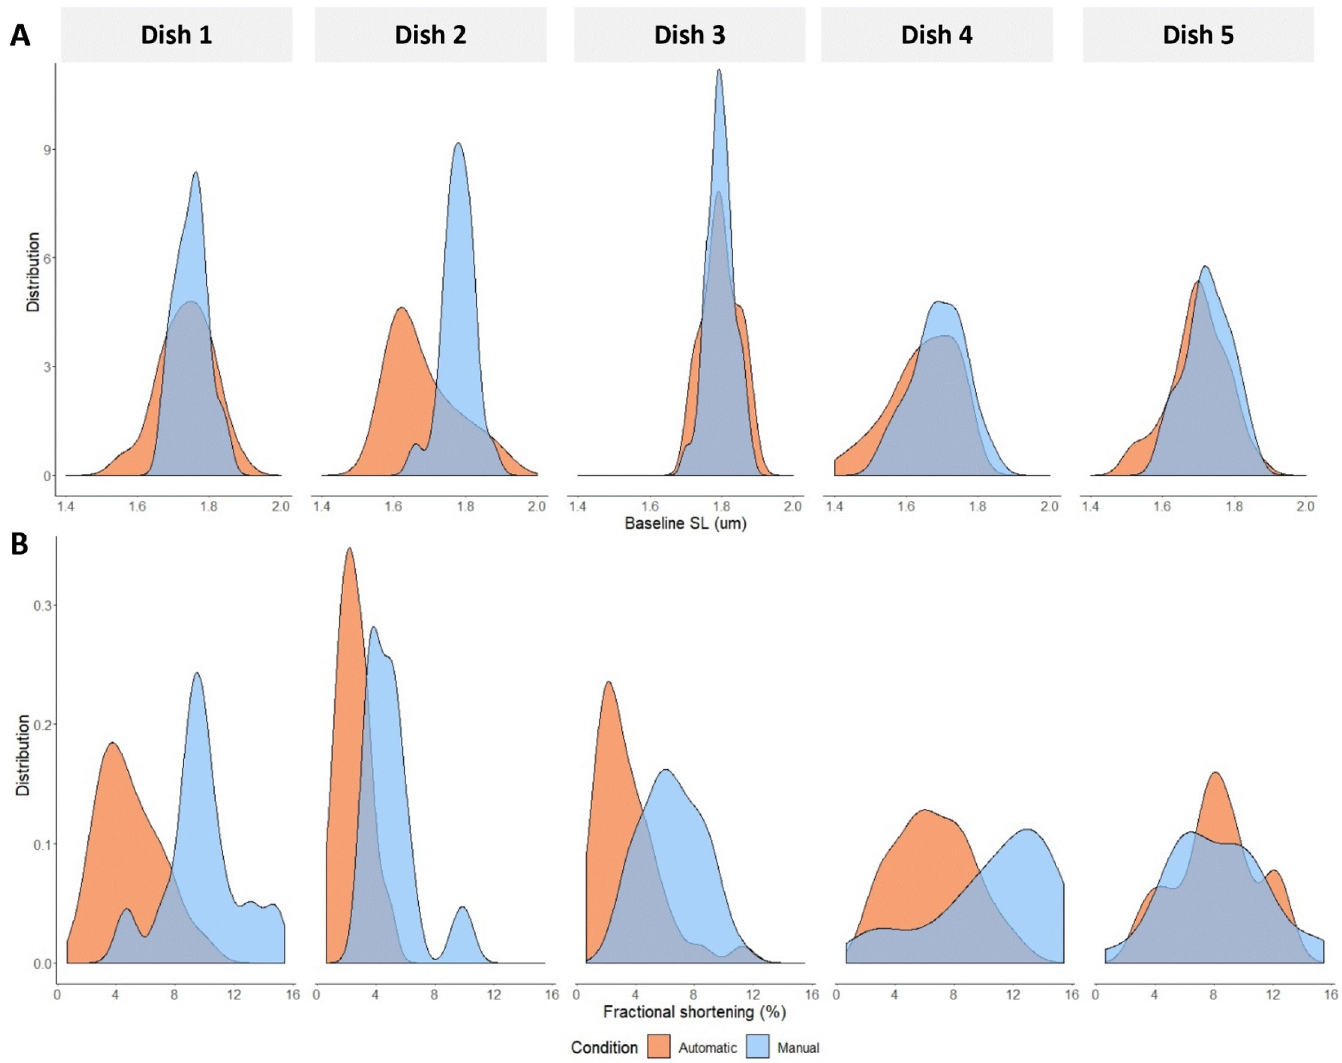
Fig 6. Data distribution of 5 dishes measured manually and automatically. A. Baseline sarcomere length (SL) distribution tends to shift to the left with automatically acquired data. B. Fractional shortening is shifted to the left in most dishes with automatically acquired data.